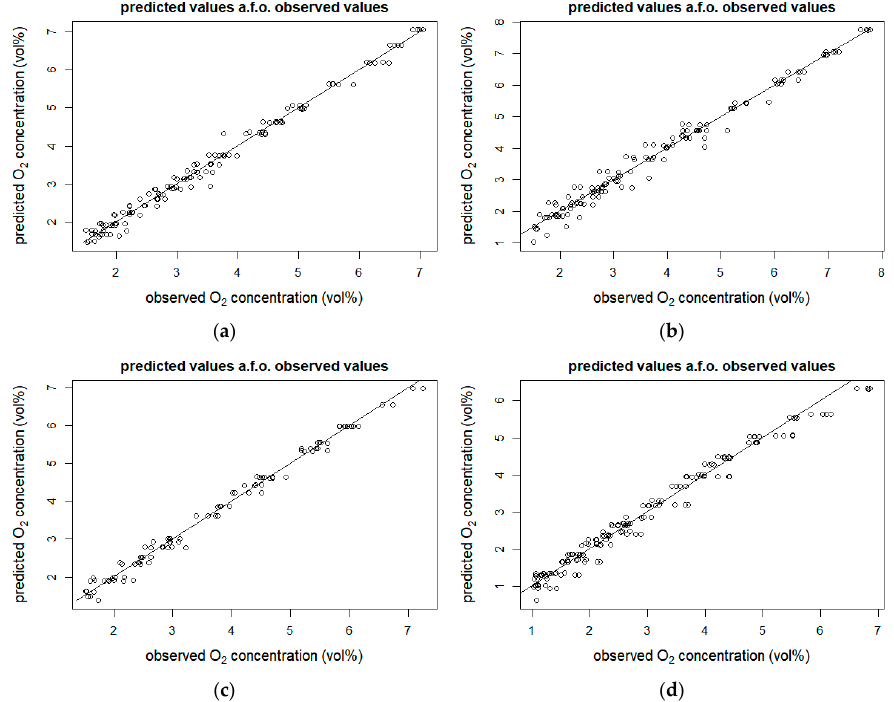
Figure 2. Predicted O 2 concentration (based on fixed effects only) as a function of the observed O 2 concentration (dots). ( a ) Phalaenopsis February; ( b ) Phalaenopsis March; ( c ) Chrysanthemum cv. B; ( d ) Chrysanthemum cv. C.